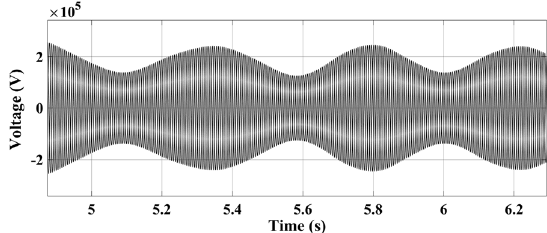
Fig. 1 The Kundur two-area system for testing